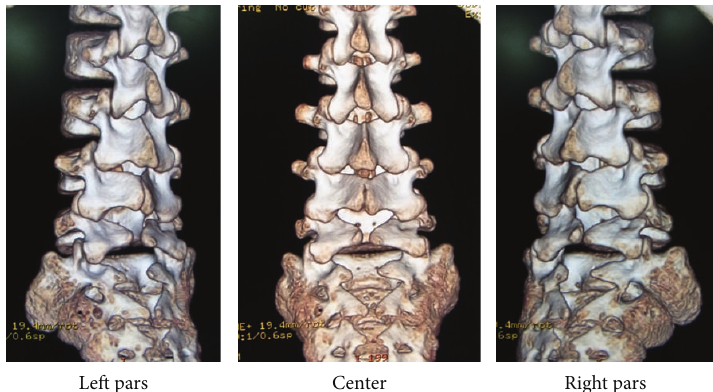
Figure 5: 3D-CT of Case 2. Note the concomitant existence of the right side L5 unilateral spondylolysis and